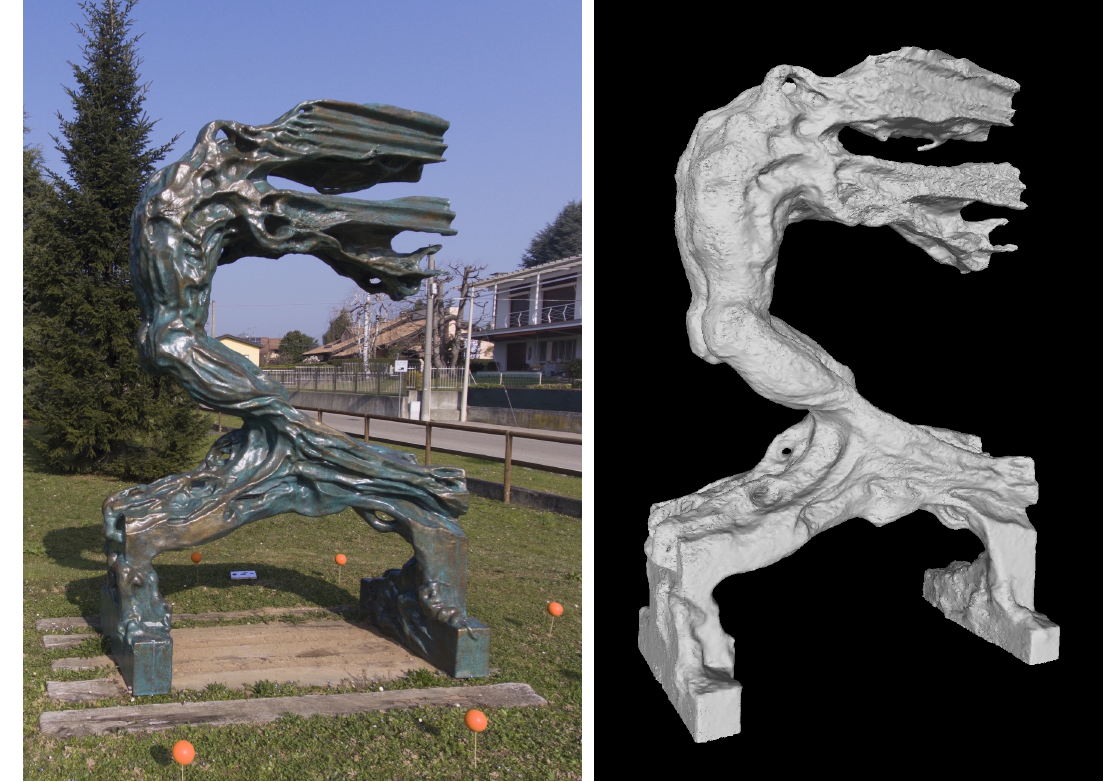
Figure 9. ( Left ) one of the acquired images from another sculpture (from the collection: warriors in the wind , by S. Volpe, Milan, Italy). ( Right ) A view of the reconstructed 3D